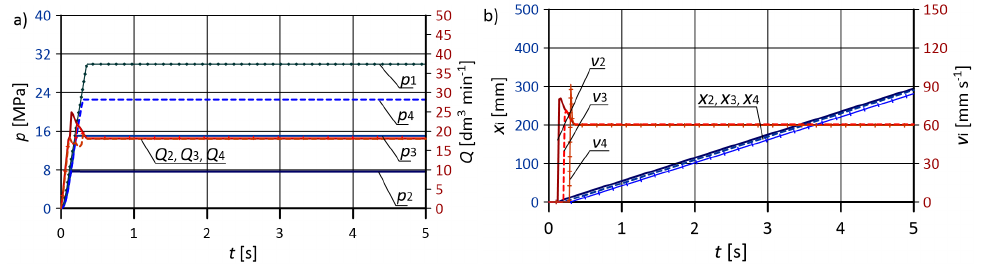
Figure 12. Results of the base system with variable load: F load ,2 = 37.5 kN, F load ,3 = 75 kN, F load ,4 = 112.5 kN and the required piston speed v i = 60.0 mm/s; ( a ) pressures and flow rates, ( b ) speeds and positions of